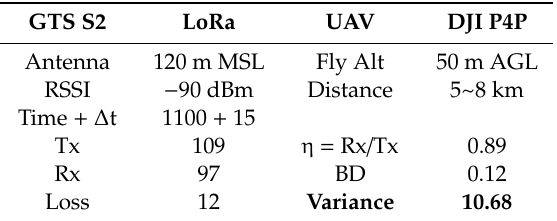
Figure 12. LoRa GTS site S2 and verification test on UTM display. Table 2. Test data at Yu-Jin (S2).